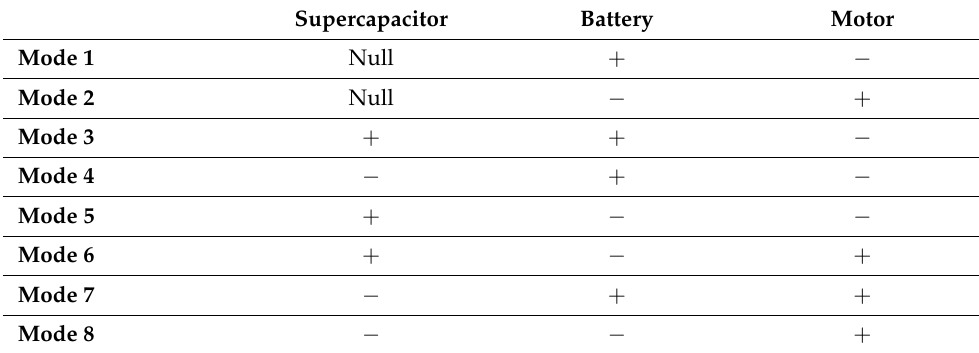
Figure 1. Proposed HESS Bq-ZSI configuration. Table 1. Operation modes of the